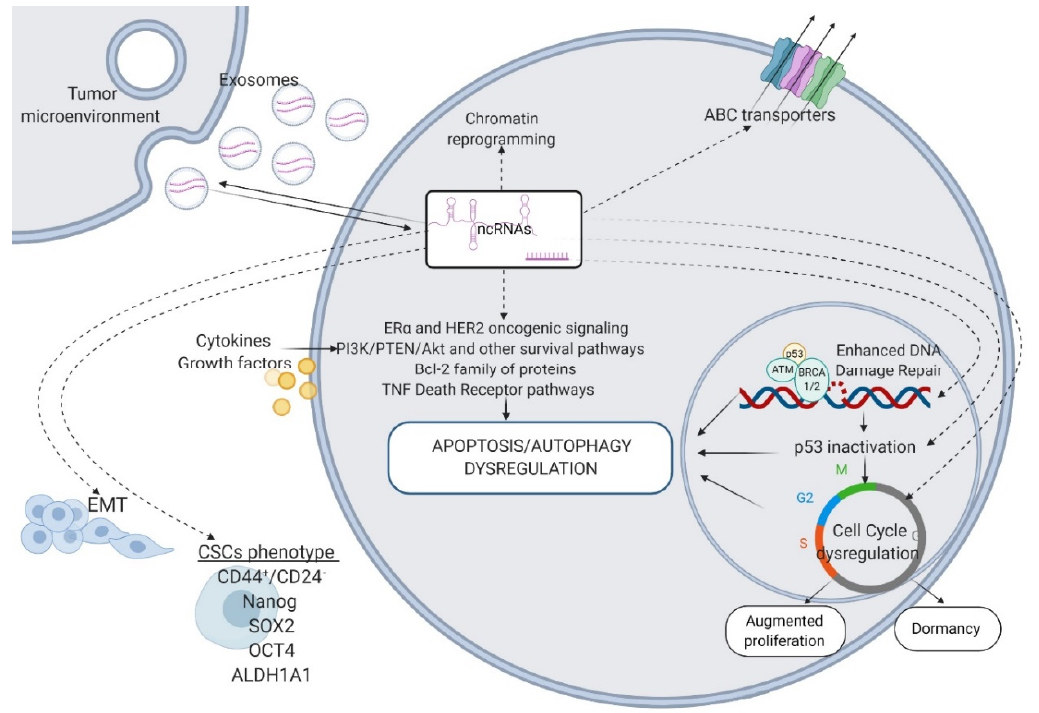
Figure 1. ncRNAs as key regulators of the mechanisms that render BC resistant to systemic therapies. ABC transporters—ATP-binding cassette transporters; Bcl-2—B-cell lymphoma 2; TNF—tumor necrosis factor; p53—tumor protein p53; ATM—Ataxia-Telangiectasia mutated; BRCA1/2—breast